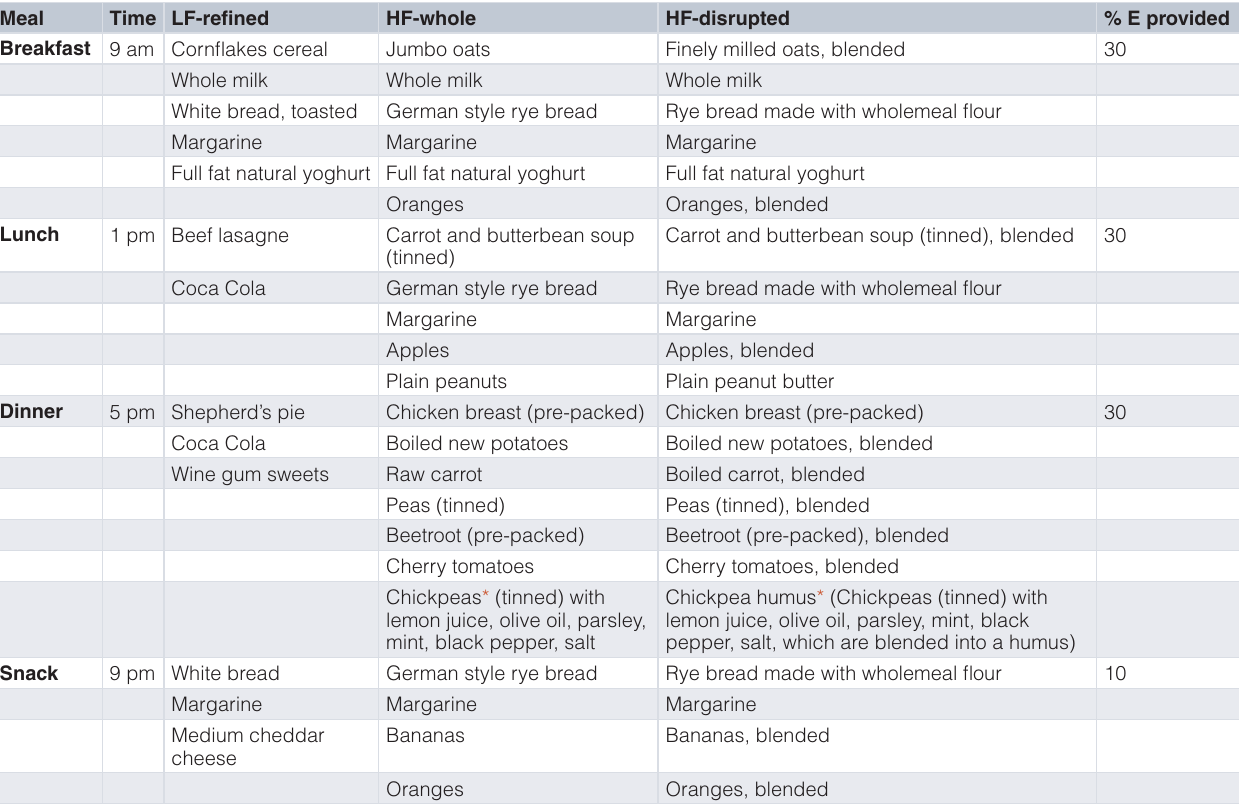
Table 2. Dietary plan for intervention